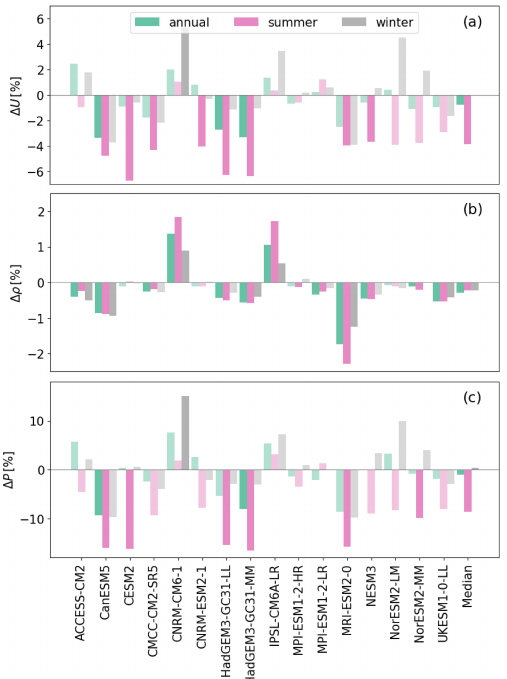
Figure A1. Relative changes in (a) wind speed, (b) surface air den- sity, and (c) wind power density between the future and the past averaged over the North Sea box. Light coloured bars are not sig- nificant at the 95%